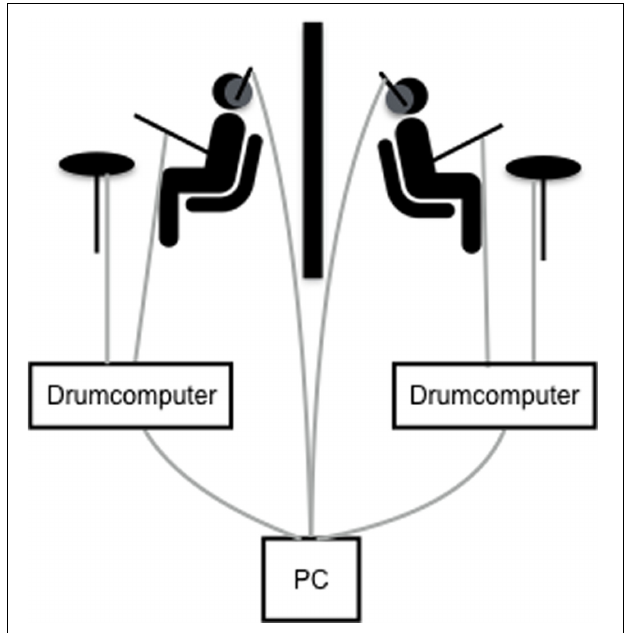
FIGURE 1 | Experimental set-up of the dyadic drumming paradigm. Participants sat back-to-back, were separated by a portable wall and drummed in symmetrical synchrony with each other or with a metronome while receiving hyper-tACS. Drum beats were digitized via the drum computer and along with auditory instructions and metronome beats sent from the PC to the participants’ headphones. Acceleration sensors were placed on the drum sticks. Cable connections depicted in